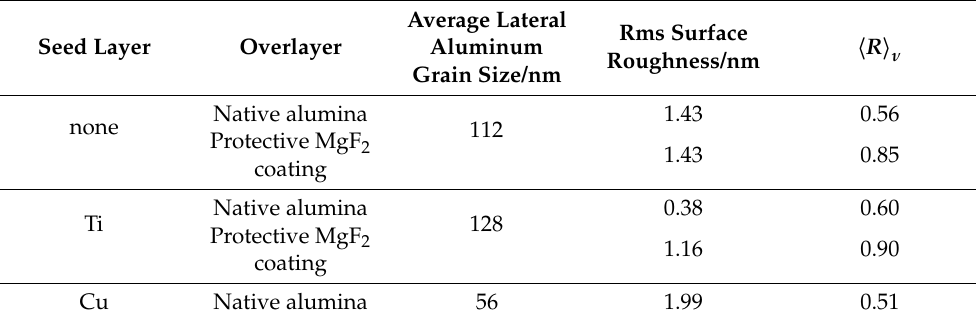
Table 1. Parameters characterizing the surface profile of the mirror coatings.